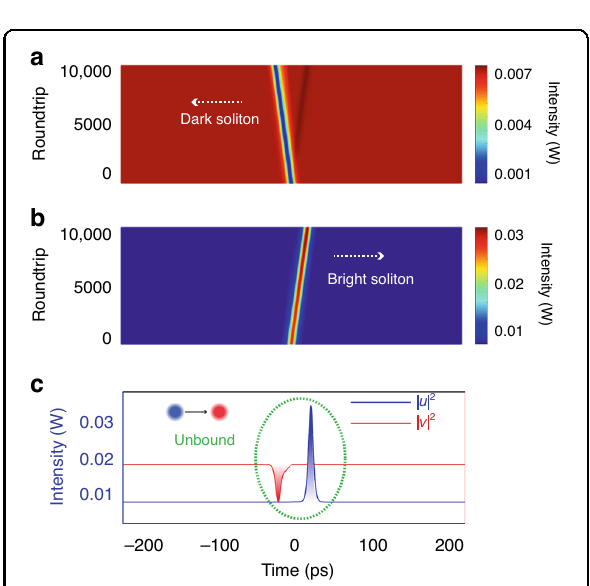
normal cavity GVD. b Evolution of BS formed in the anomalous cavity GVD. c Red solid line and blue solid line: DS and BS observed at the